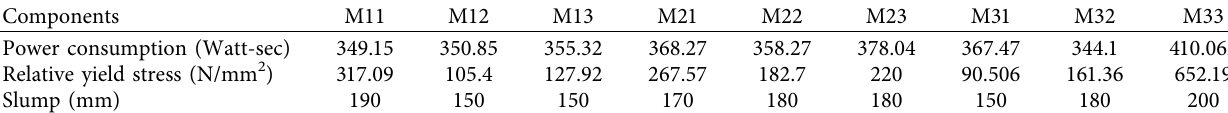
Table 11: Power consumption, relative yield stress, and slump for M25, M30, and M40 grade concrete. Components